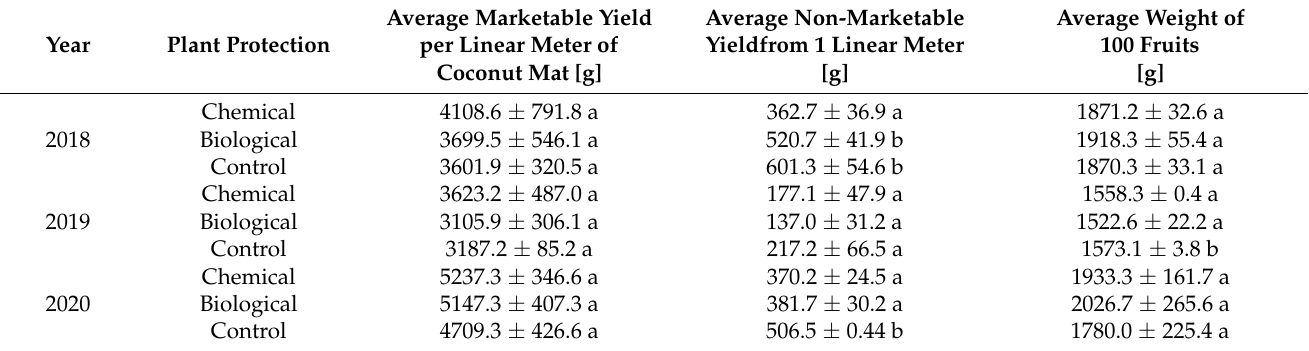
Table 1. Fruit yield of ‘San Andreas’ directly after